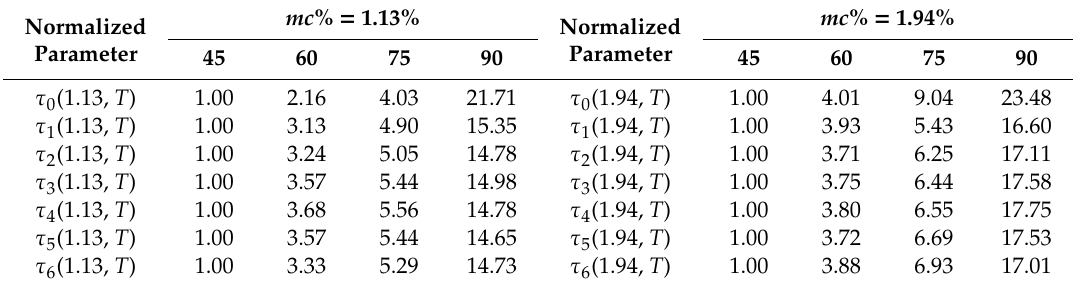
Table 5. Normalized parameters τ j ( mc %, T ) with moisture content of 2.28% and 3.36%. mc % = 2.28% Normalized Normalized Parameter 45 60 Parameter τ 0 (2.28, T )